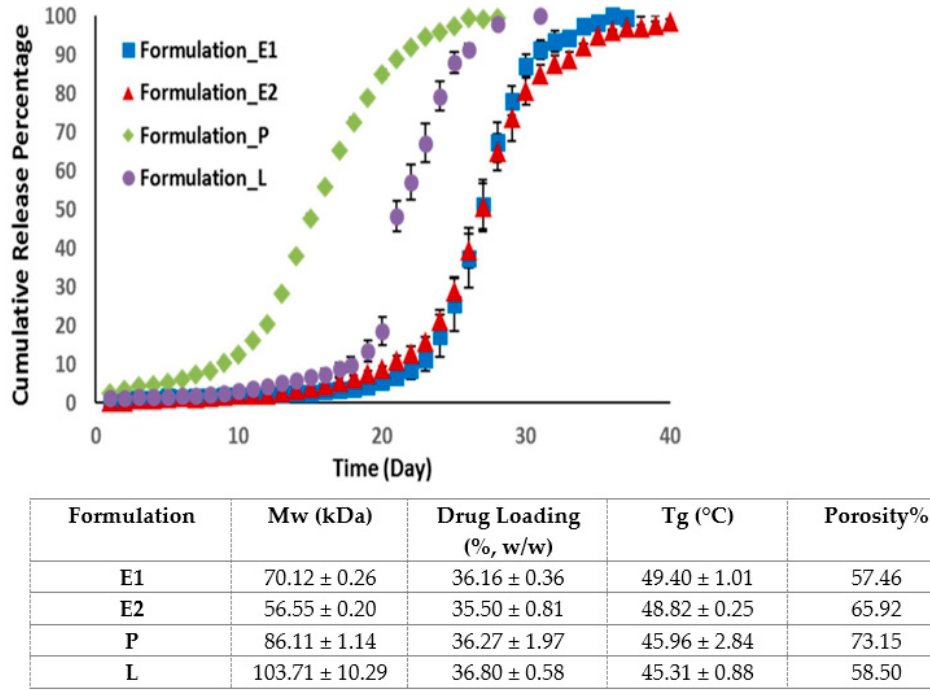
Figure 2. Cumulative release of risperidone from four microsphere formulations with similar drug loading but different porosities and glass transition temperatures. Formulation P, with a high porosity % but a low Tg, displayed the fastest drug release. (Adapted from International Journal of Pharmaceutics , 582, Moe Kohno, Janki V. Andhariya, Bo Wan, Quanying Bao, Sam Rothstein, Michael Hezel, Yan Wang and Diane J. Burgess, The effect of PLGA molecular weight differences on risperidone release from microspheres, 119339, Copyright (2020), with permission from Elsevier [43]).